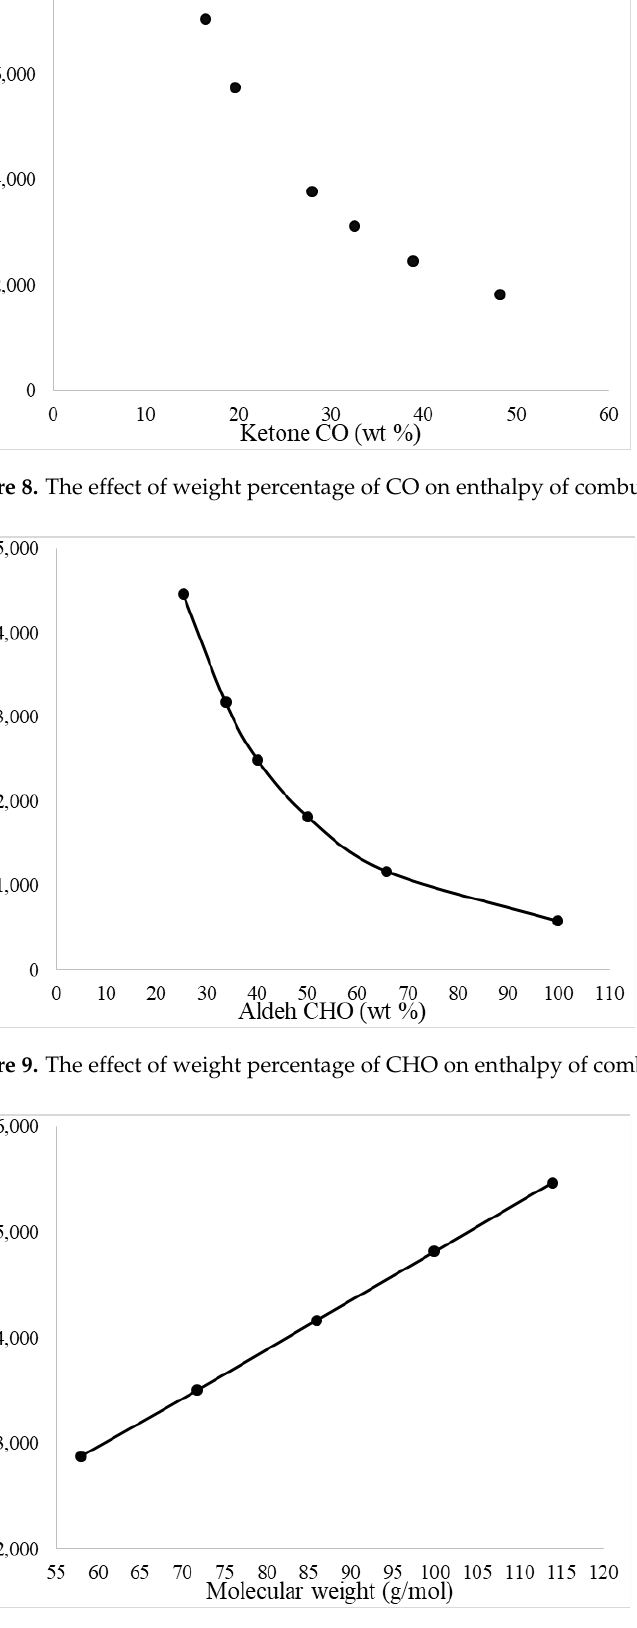
Figure 10. The effect of molecular weight of iso-paraffins on enthalpy of combustion .